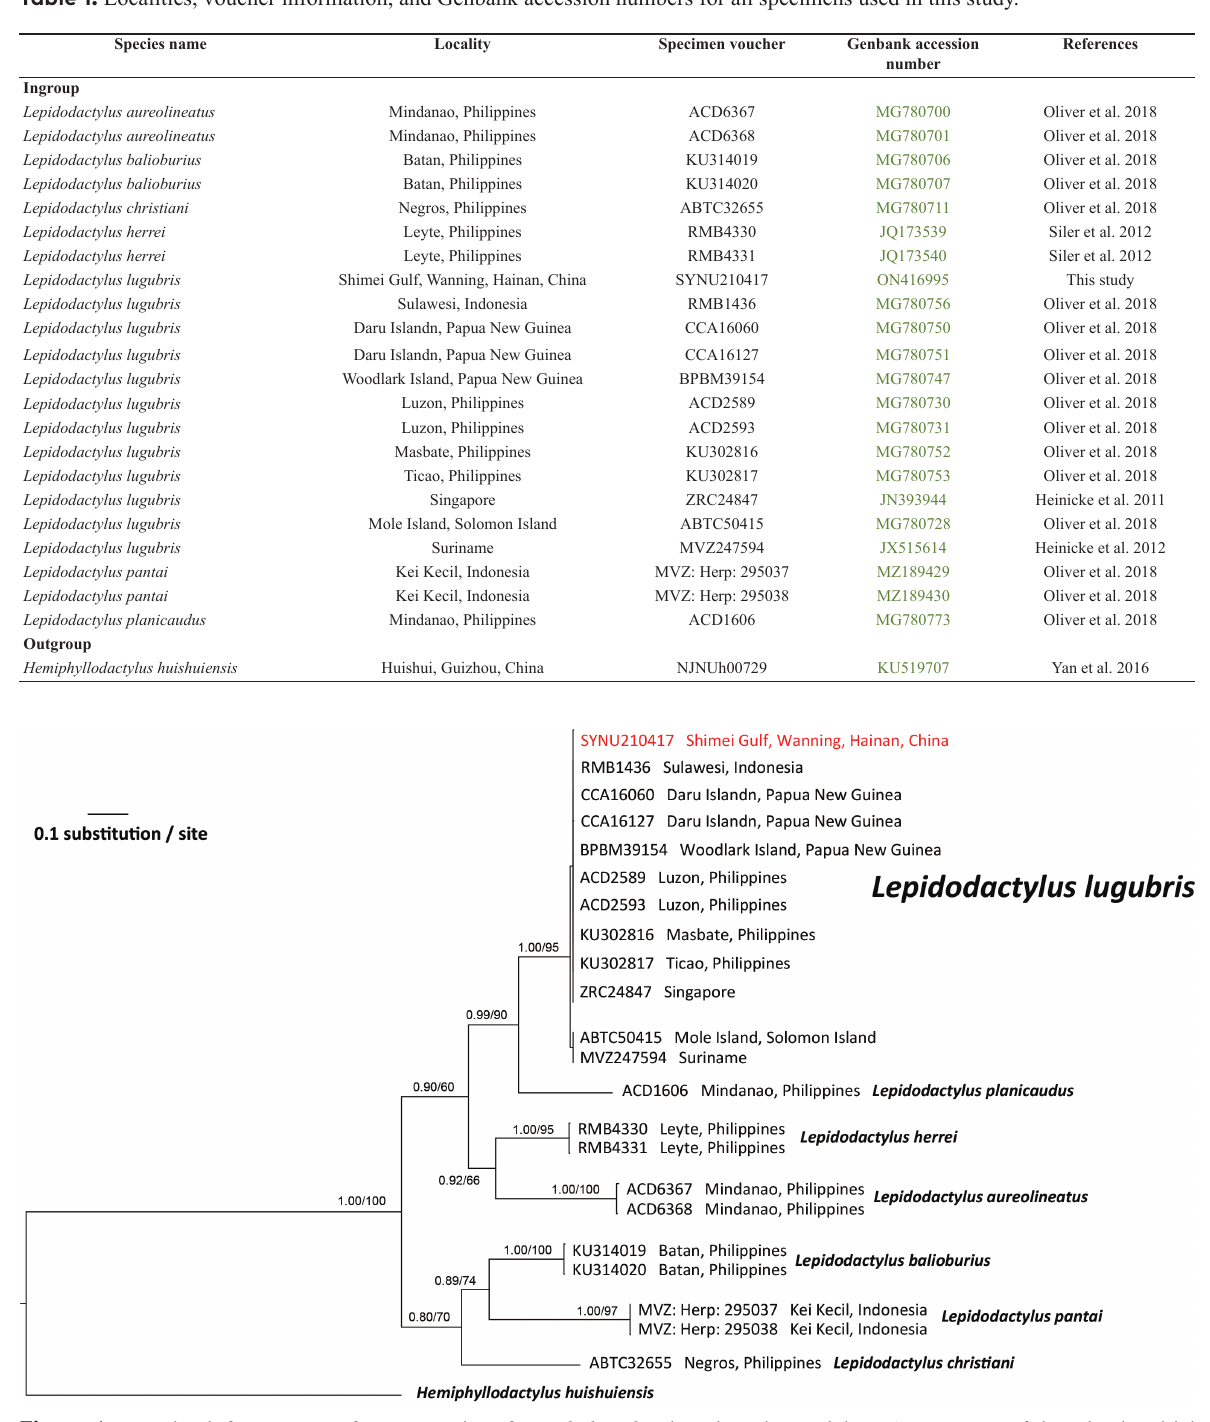
Figure 1. Bayesian inference tree of seven species of Lepidodactylus , based on the partial DNA sequences of the mitochondrial ND2 gene. Numbers before slash indicate Bayesian posterior probabilities (BPP) and numbers after slash are bootstrap support for ML (1000 replicates)